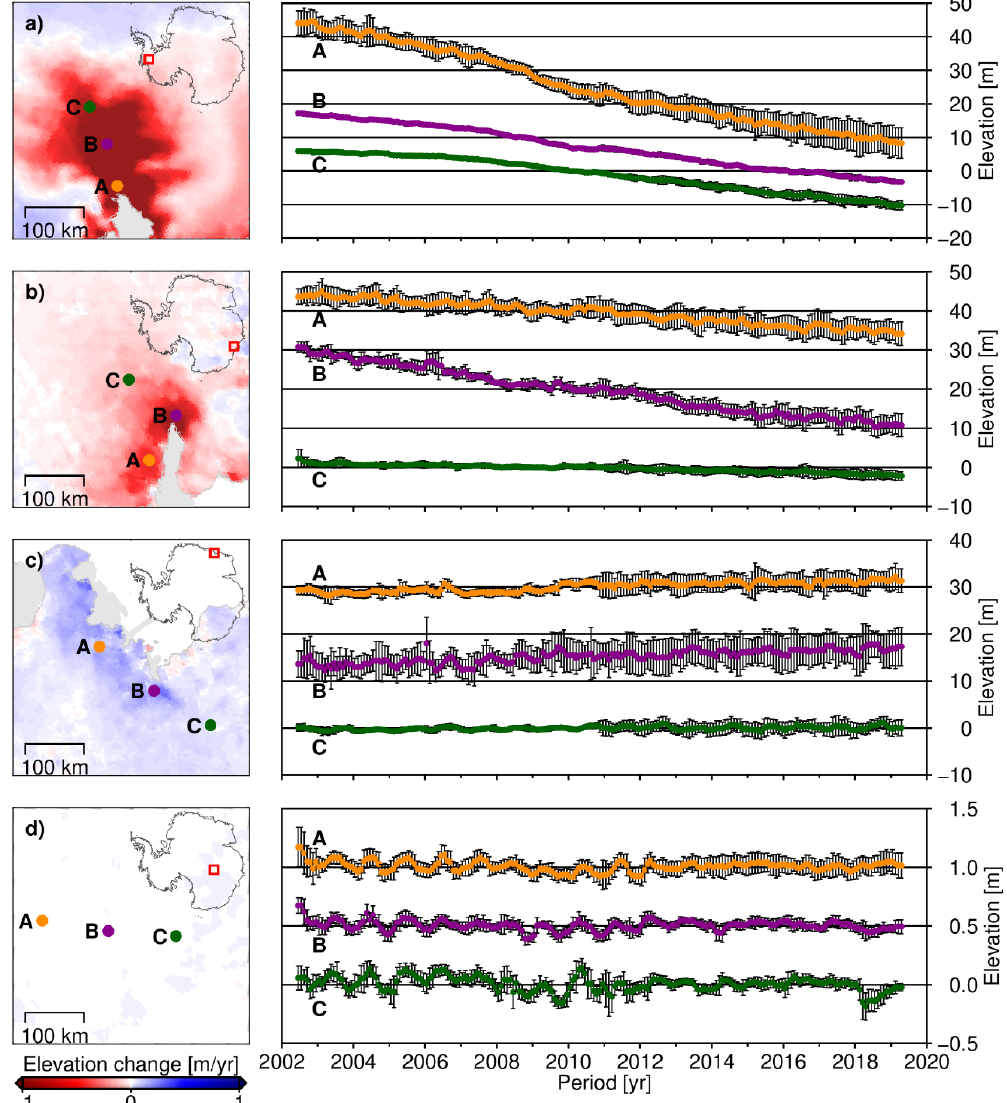
Figure 4. Elevation time series for Pine Island Glacier ( a ), Totten Glacier ( b ), Dronning Maud Land ( c ), and Lake Vostok ( d ). The geographical locations of the selected points (A, B, and C) are marked in green, purple, and orange on the left maps of elevation changes over 2002–2017. The time series and their 1 σ uncertainty ranges for each point are given in the right maps. The time series of the points A and B are shifted along the Elevation axis for better